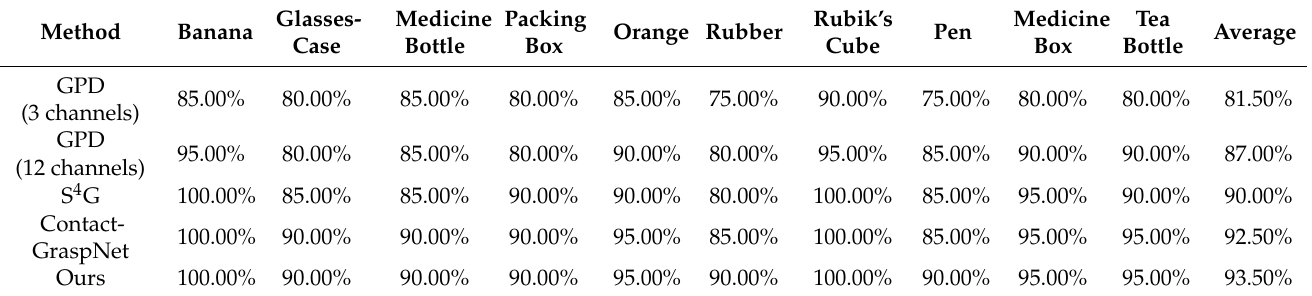
Table 5. Experimental results of single-object grasping.